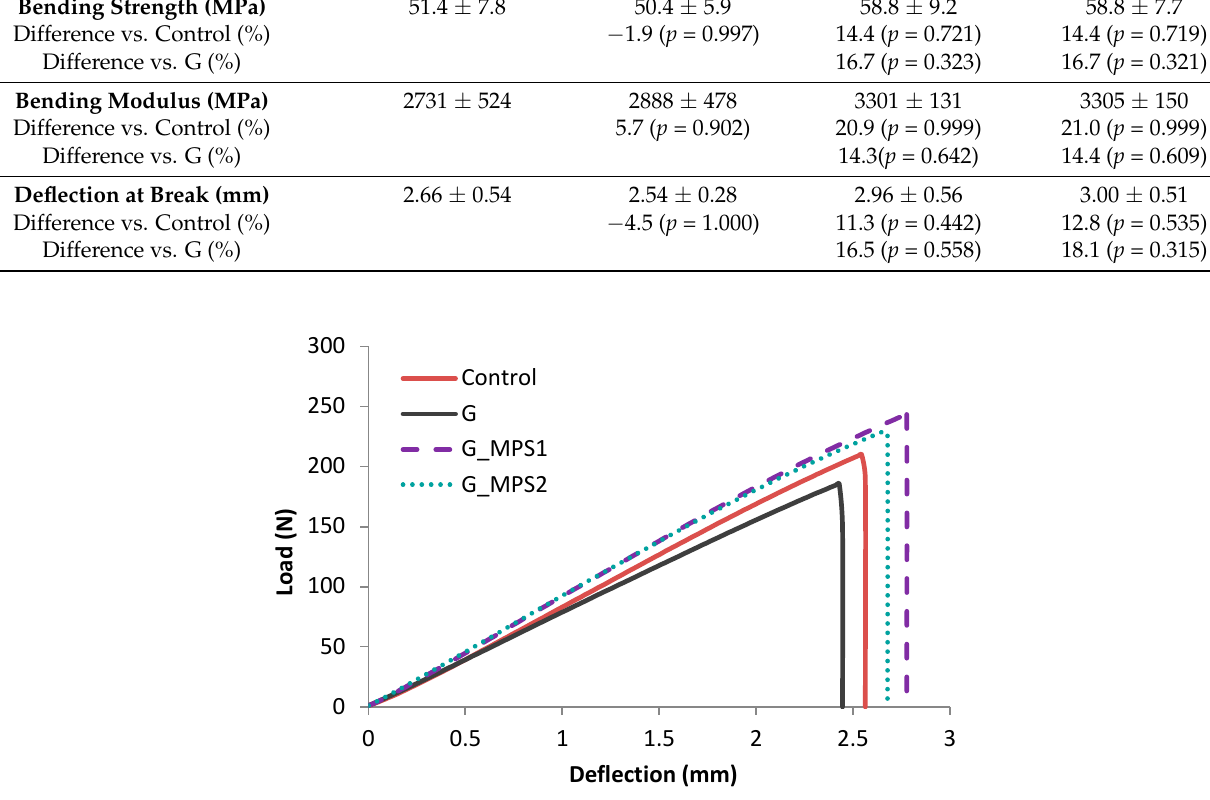
Figure 2. Comparison of Load (N) vs. Deflection (mm) obtained from representative bending tests for Control and bone cements with 0.1 wt.% of G, G_MPS1 and G_MPS2.